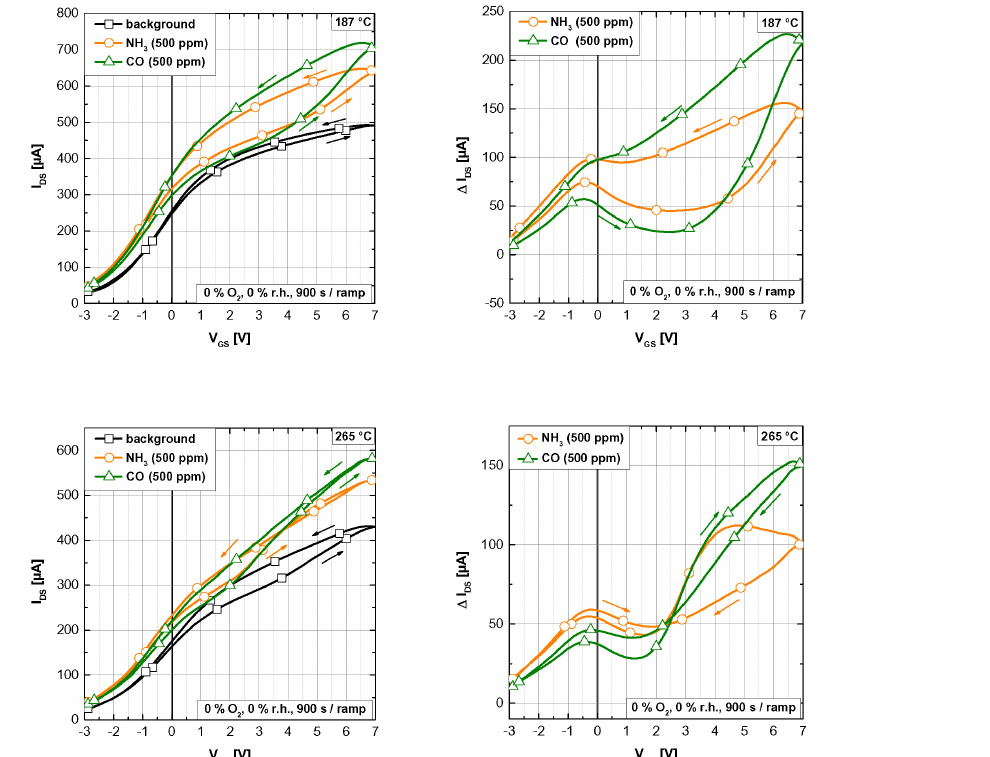
Figure 4. The absolute sensor response (a, c) and the di ff erence signal vs. background ∆ I DS = I DS (gas) − I DS (background) (b, d) for a background of dry nitrogen (black, rectangles) as well as 500ppm ammonia (orange, circles) and 500ppm CO (green, triangles) at 187 ◦ C (a, b) and 265 ◦ C (c, d) .